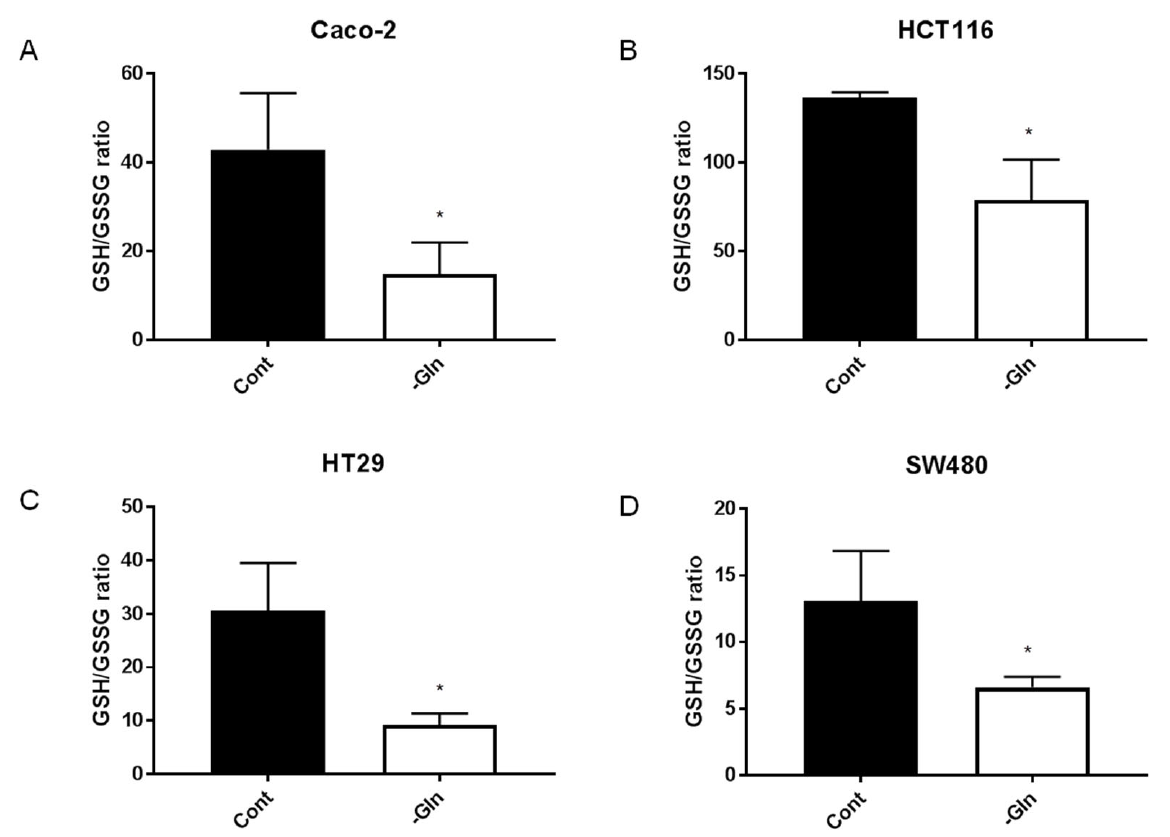
Figure 8. Glutamine starvation significantly decreased intracellular antioxidant defenses in ( A ) Caco- 2, ( B ) HCT116, ( C ) HT29, ( D ) SW480. GSH and GSSG levels were measured by HPLC in col ‐ orectal cancer cells after 48h of glutamine deprivation condition. Experiments were performed in triplicate and data were expressed as mean ± SD ( n = 3, * p < 0.05).